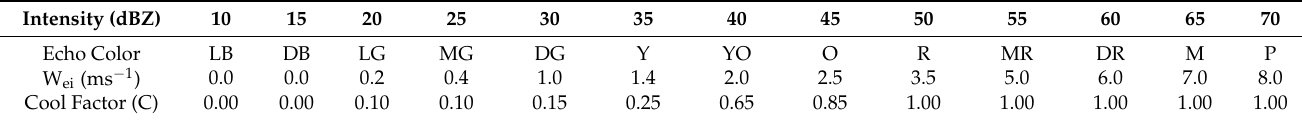
Table 1. Radar/Wind Model Conversion